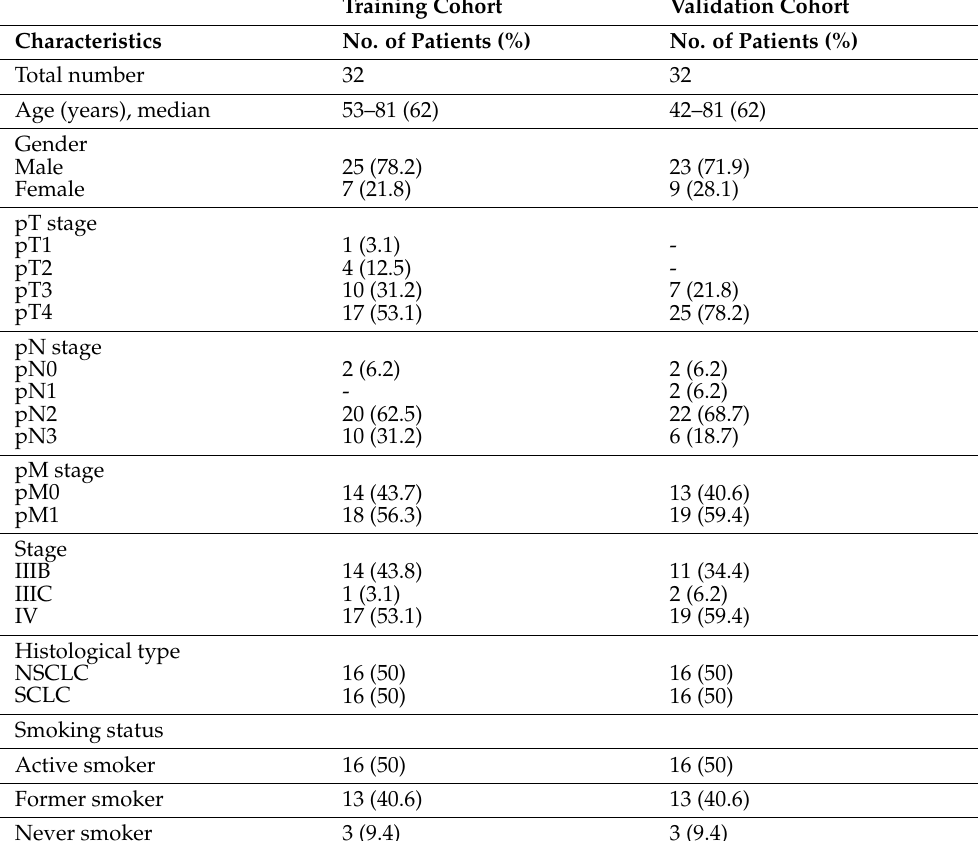
Table 1. Baseline clinicopathological characteristics of lung cancer patients in the cohorts.